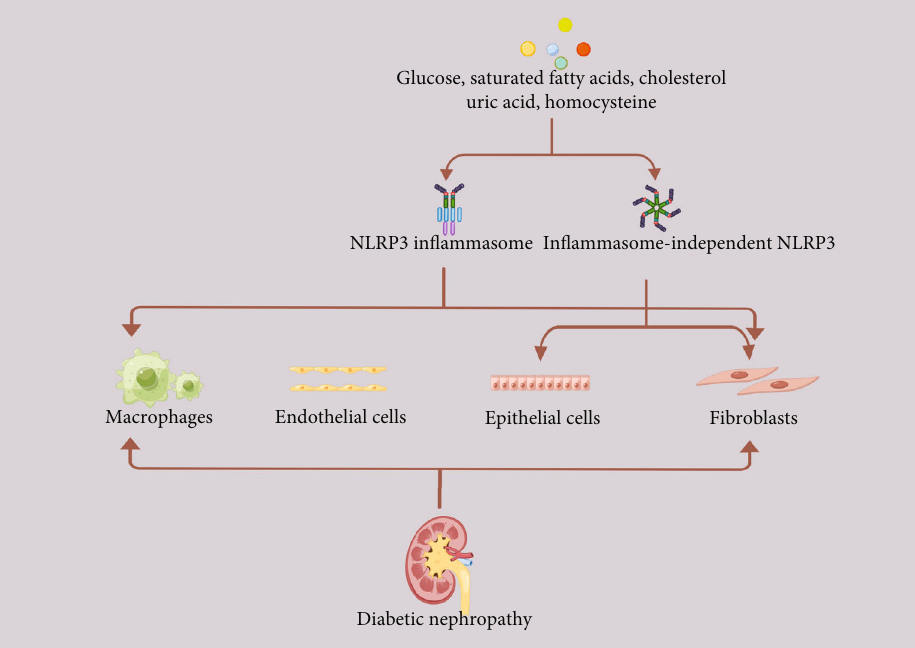
Figure 2: Role of in fl ammasome-independent NLRP3 and the NLRP3 in fl ammasome in the pathogenesis of diabetic